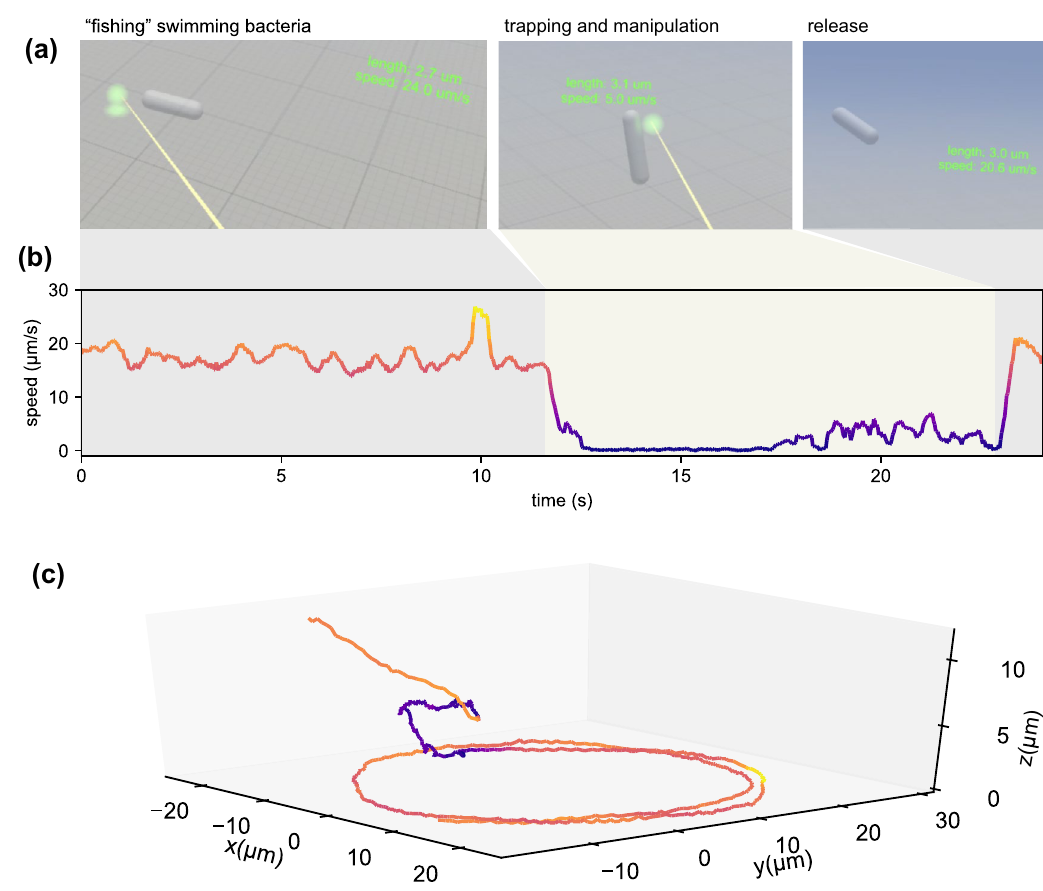
Figure 5. ( a ) The movie frames show the user view as he aims at a swimming E. coli cell, traps it and finally releases it. The VR application displays an info panel for each cell showing size and speed. ( b ) Cell speed as a function of time during the interaction summarized by the frames above. ( c ) Full 3D trajectory of the cell showing circular swimming of the free cell, trapping and manipulation (slow speed section) and finally release. The color of the curve corresponds to speed values as shown in ( b ). See also Supplementary Video 3. This figure was made using Unity 28 and Matplotlib 38